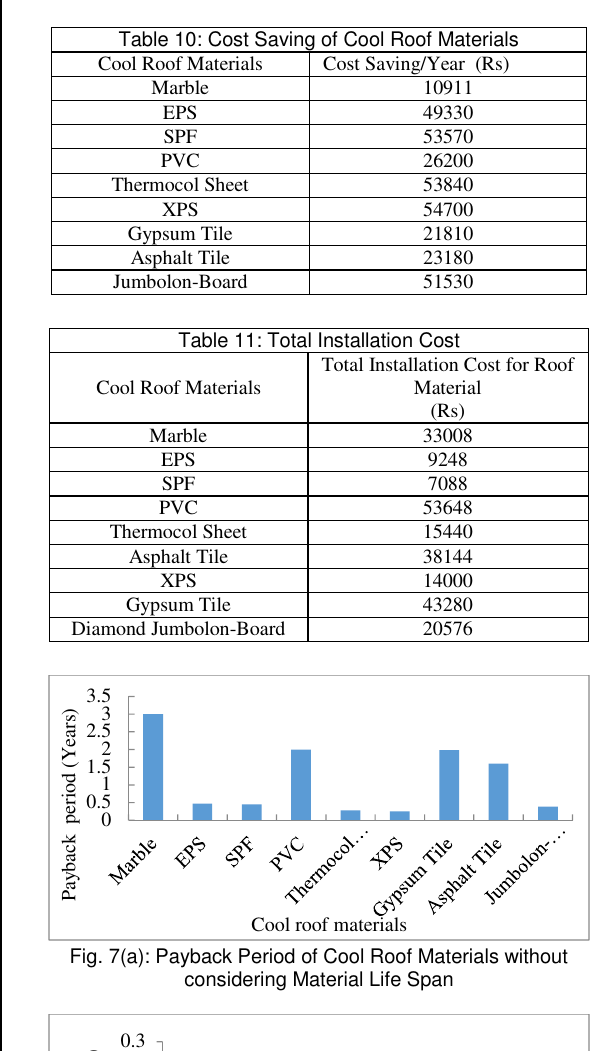
Table 8: Cost of Cool Roof Materials Cool Roof Material Cost/sq.m Marble